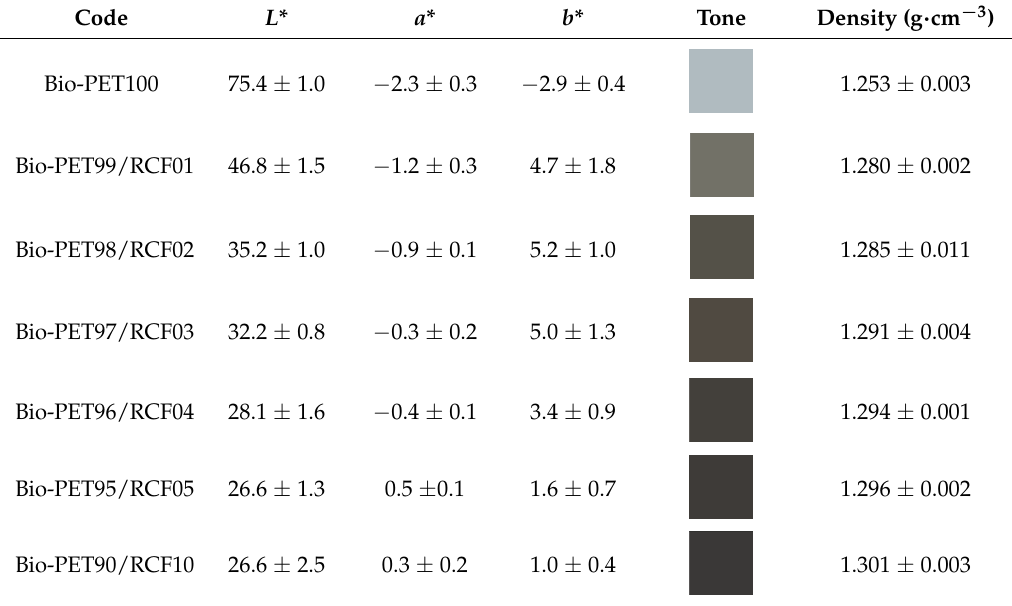
L* : luminosity (+L luminous, − L dark); a* : red/green coordinates (+a red, − a green); b* : yellow/blue coordinates (+b yellow, − b blue).